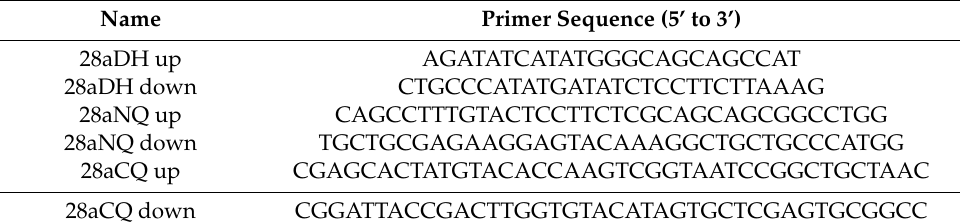
Table 4. The detail of site directed mutagenesis